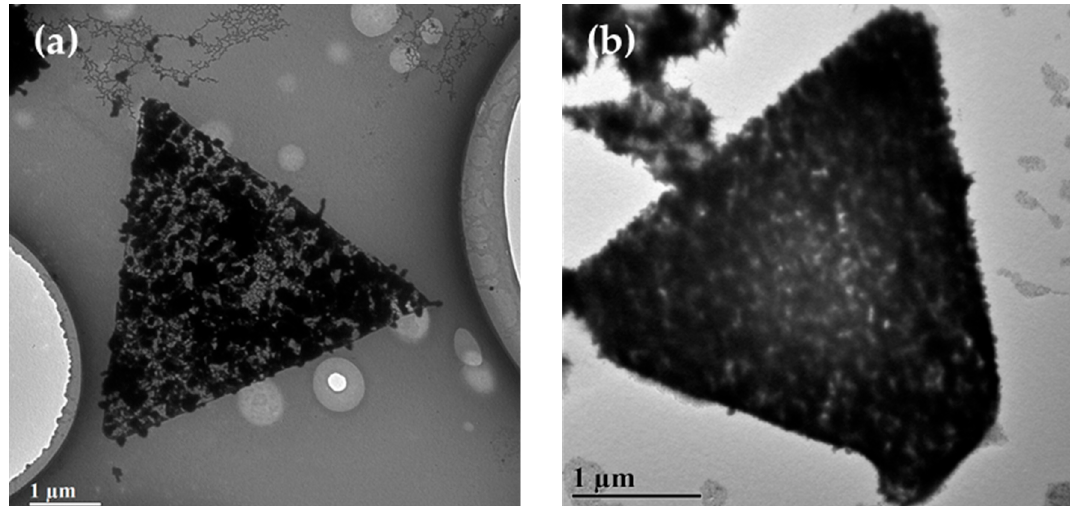
Figure 4. Formation and growth of Ag@AuCu trigonal nanoplates with a moderate concentration of AgNO 3 (200 µ L) at di ff erent reaction times. ( a ) A porous trigonal nanoplate of self-assembled Ag@AuCu nanocrystals with an average side length of 4.85 ± 0.1 µ m. ( b ) A high-dense trigonal nanoplate with star-branches on the boundary. The average side length is 2.92 ± 0.1 µ m.